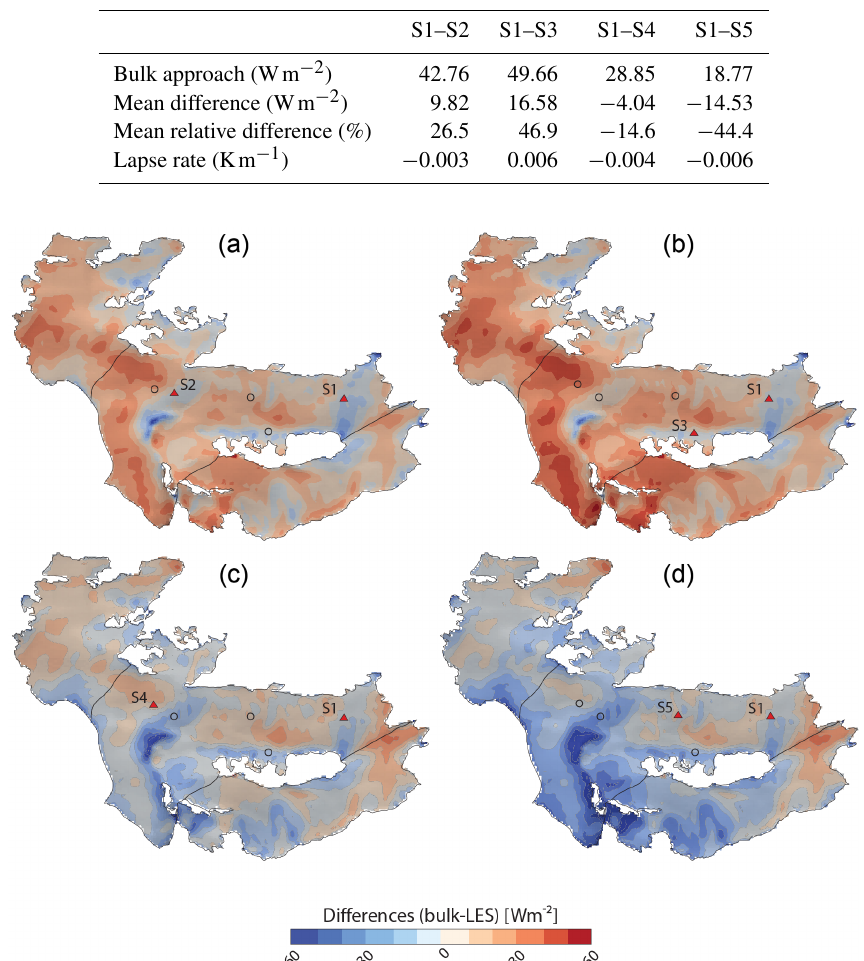
Table 3. Mean glacier-wide sensible heat fluxes using the bulk approach with linearly extrapolated temperature and wind fields. The table shows extrapolation scenarios based on different pseudo-observations (S1, S2–S5). The exact location of the pseudo-observations is given in Fig. 11. Given are the mean and relative differences between the bulk estimates and LES as well as the lapse rates. Positive differences correspond to an overestimation of the fluxes by the bulk approach.